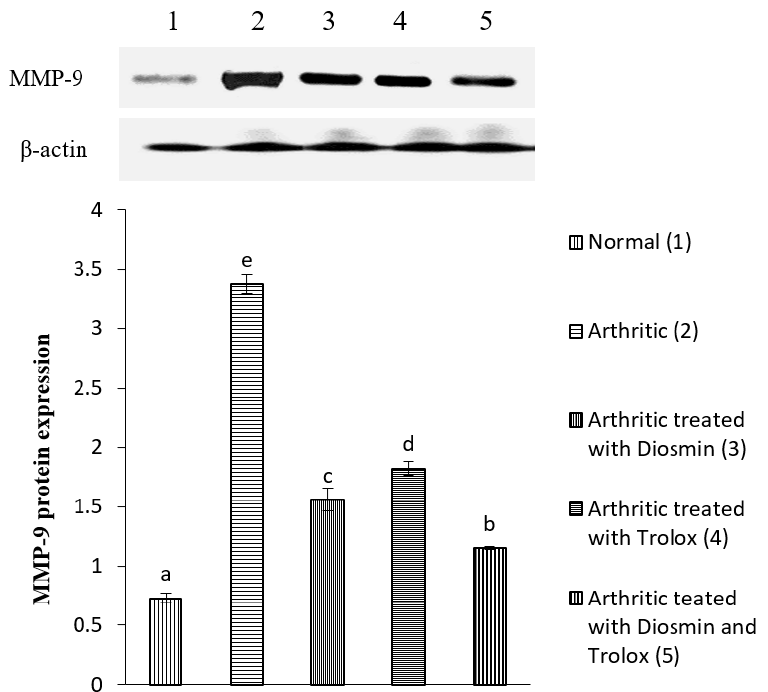
Figure 10. Effect of diosmin, trolox and their combination on MMP-9 protein expression level in CFA-induced arthritic rats. Means, that have the same symbol (s) are not significantly different ( n = 3).